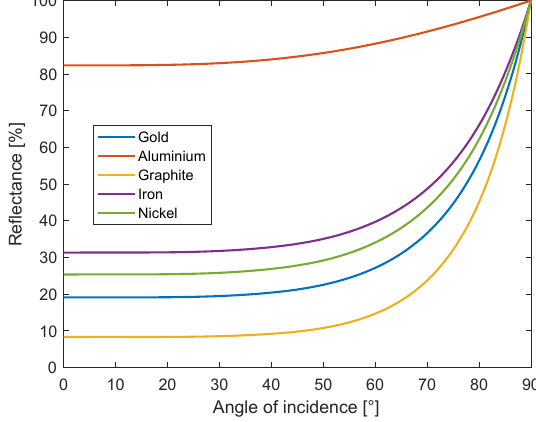
Figure 5. Photoelectric yield as a function of wavelength for the five different materials: gold, aluminium, stainless steel, graphite and nickel. The dashed part of the nickel curve shows the interpolated data.